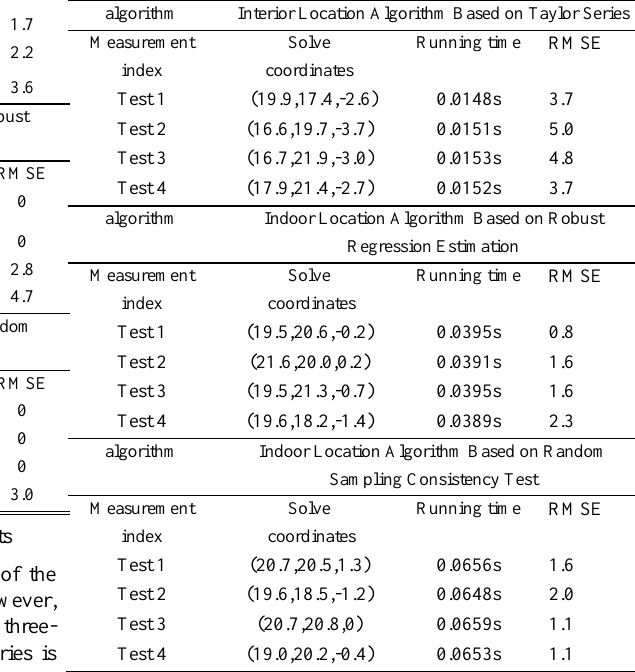
Table 3 Three algorithms to simulate the positioning